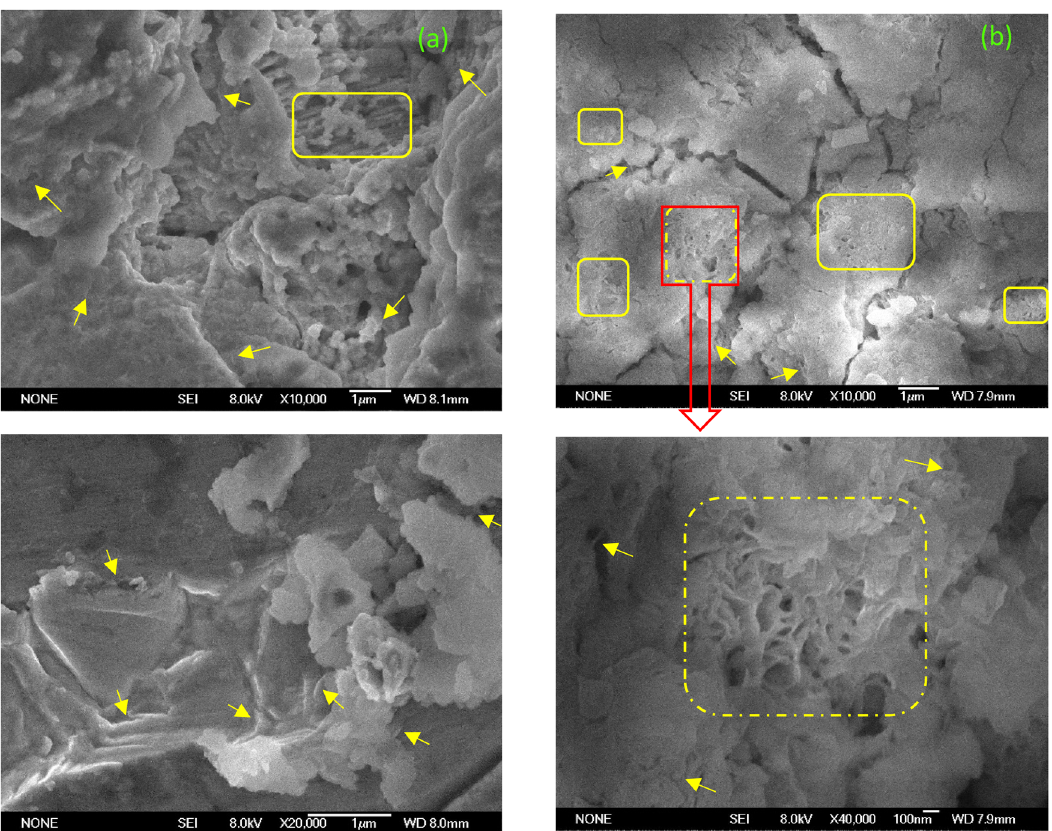
Figure 4: SEM images: ( a ) MCNT/CM; zoomed with 10k, 20k ( top - left, bottom - left ) ; ( b ) MNTSM zoomed with 10k, local enlargement red box of top - right image ( top - right, top - bottom ) ( arrow - single CNT; rounded rectangle – CNT agglomerations ) .